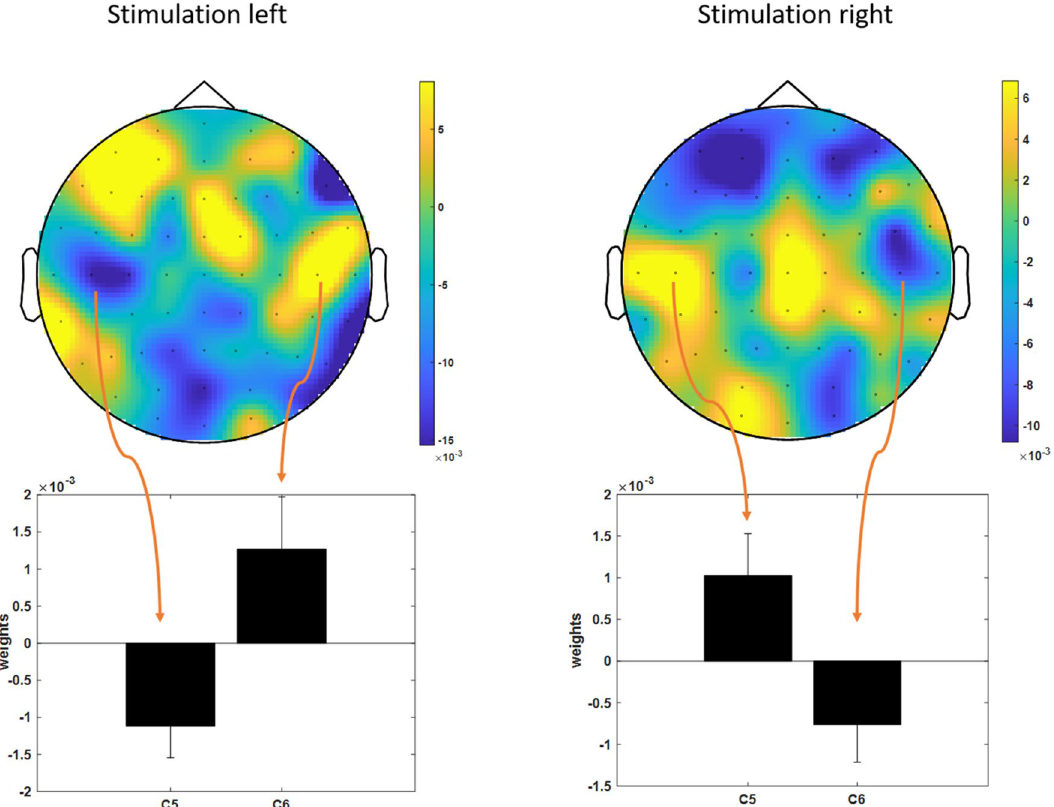
Figure 2. Topographical distribution of prediction weights in the high gamma band (60:120 Hz) showed a fronto-central focus. Over lateral central sites a lateralization was observed in correspondence to the stimulation site. For stimulation at the left hand the classification of painful trial resulted pre-stimulus in positive weights over the contralateral cortex and negative weights over the ipsilateral cortex and vice versa for right hand stimulations as shown for electrodes C5 and C6 below.